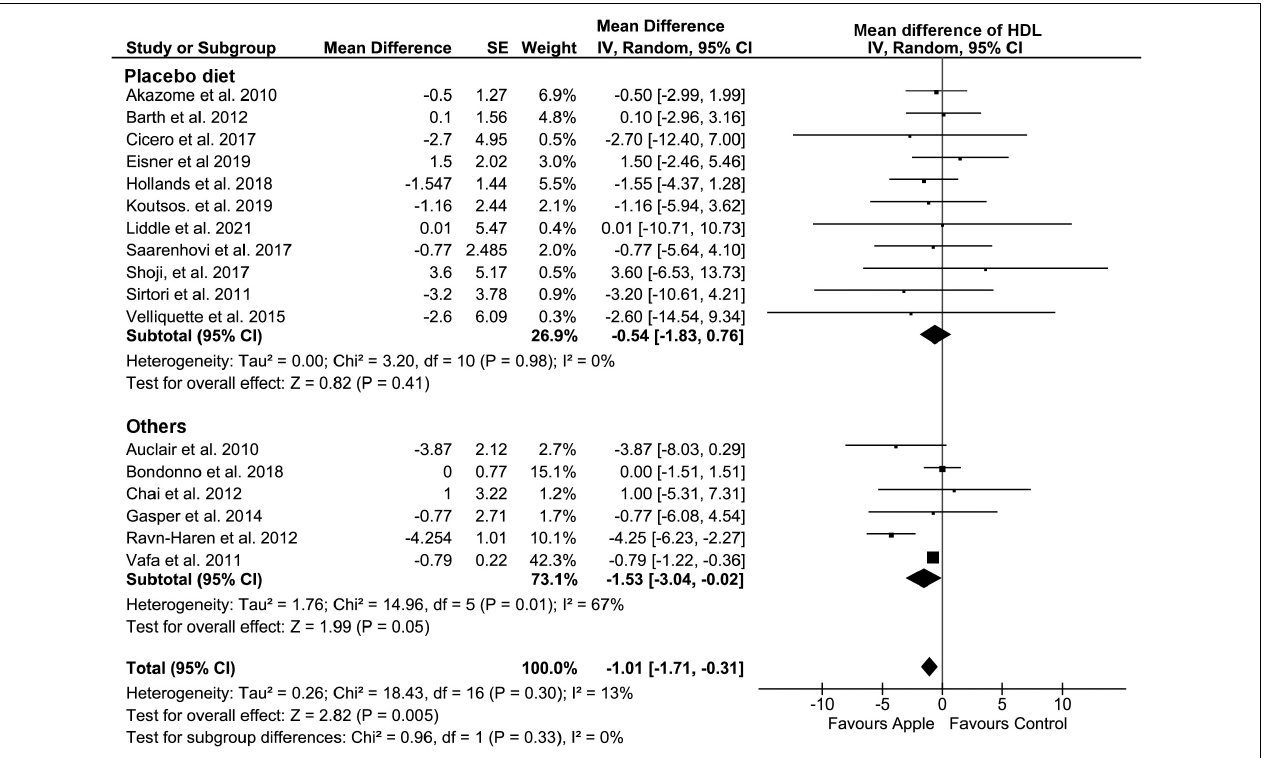
FIGURE 4 | Meta-analysis results of high-density lipoprotein. Forest plot is stratified by placebo diet or other alternative diets.